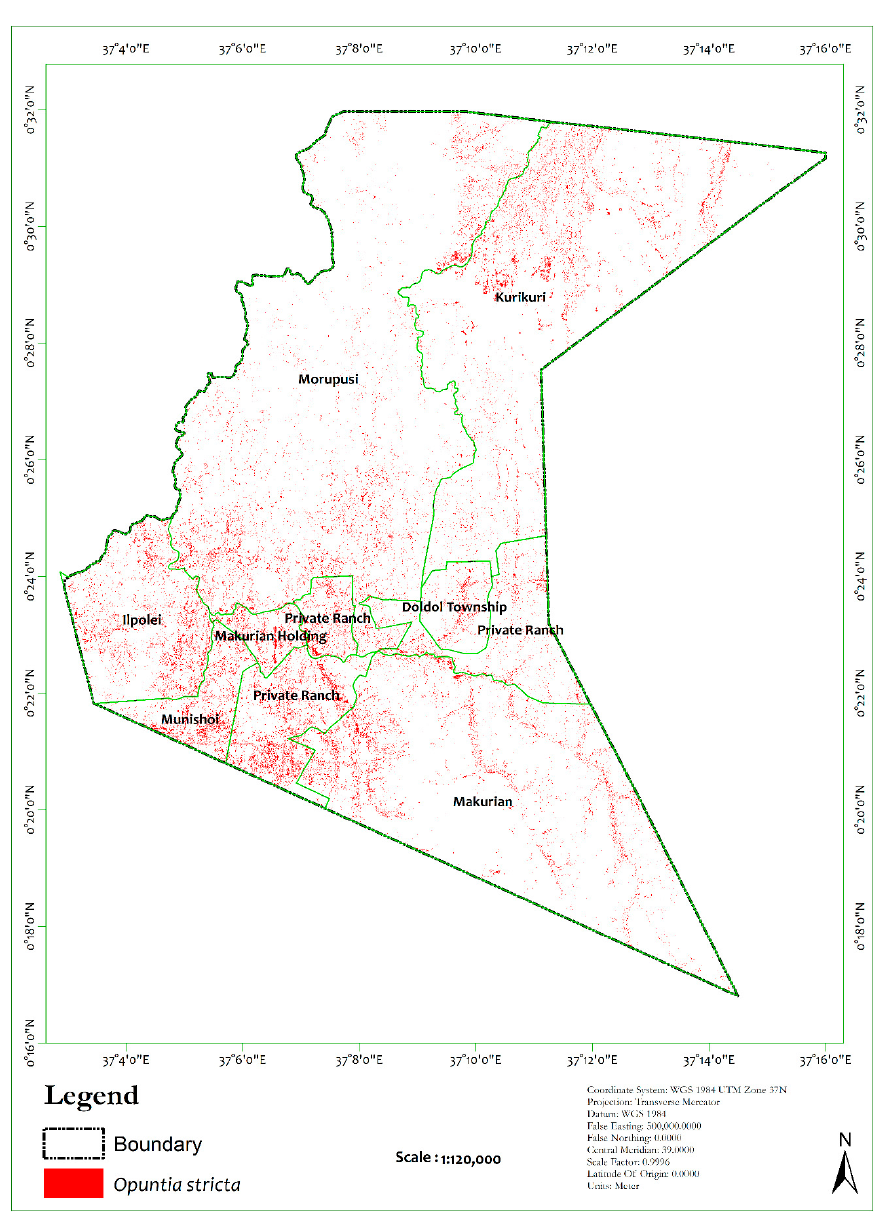
Figure 7. Map showing Opuntia stricta mask based on model